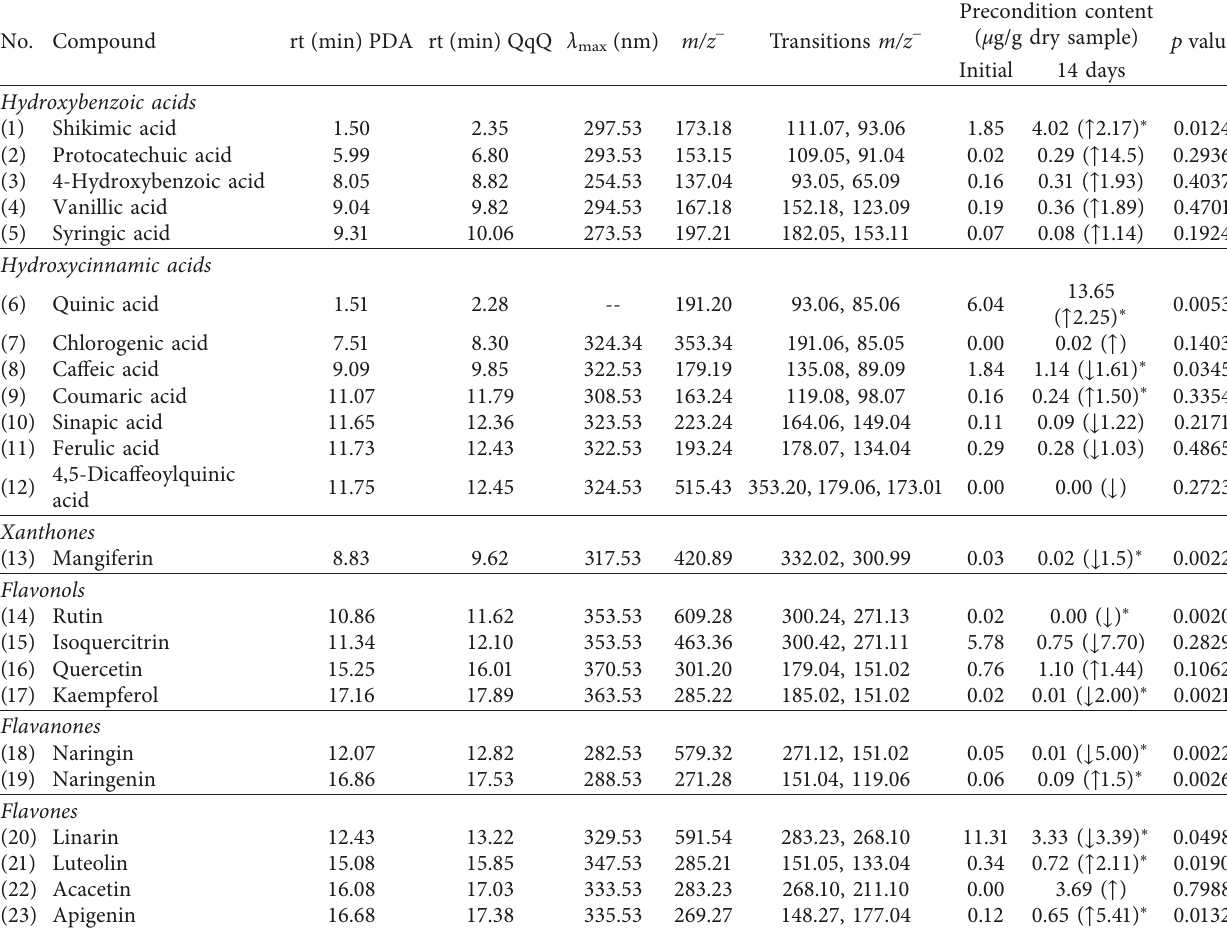
Table 2: Accumulation levels of phytochemical compounds in Buddleja scordioides plants preconditioned at 25 °